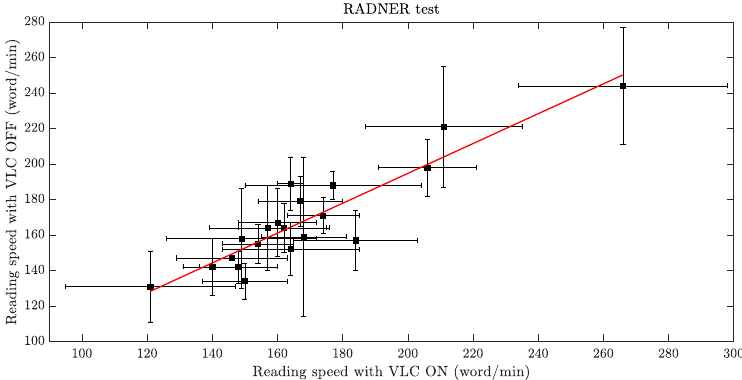
Figure 7. Scatter plot between v ON ˘ σ ON and v OFF ˘ σ OFF for each examined subject when taking the Radner test. The figure also displays the linear regression fit, represented by the equation y “ 0.84 x ` 26.53, and the Pearson correlation coefficient R “ 0.91. There is a positive correlation between v ON and v OFF